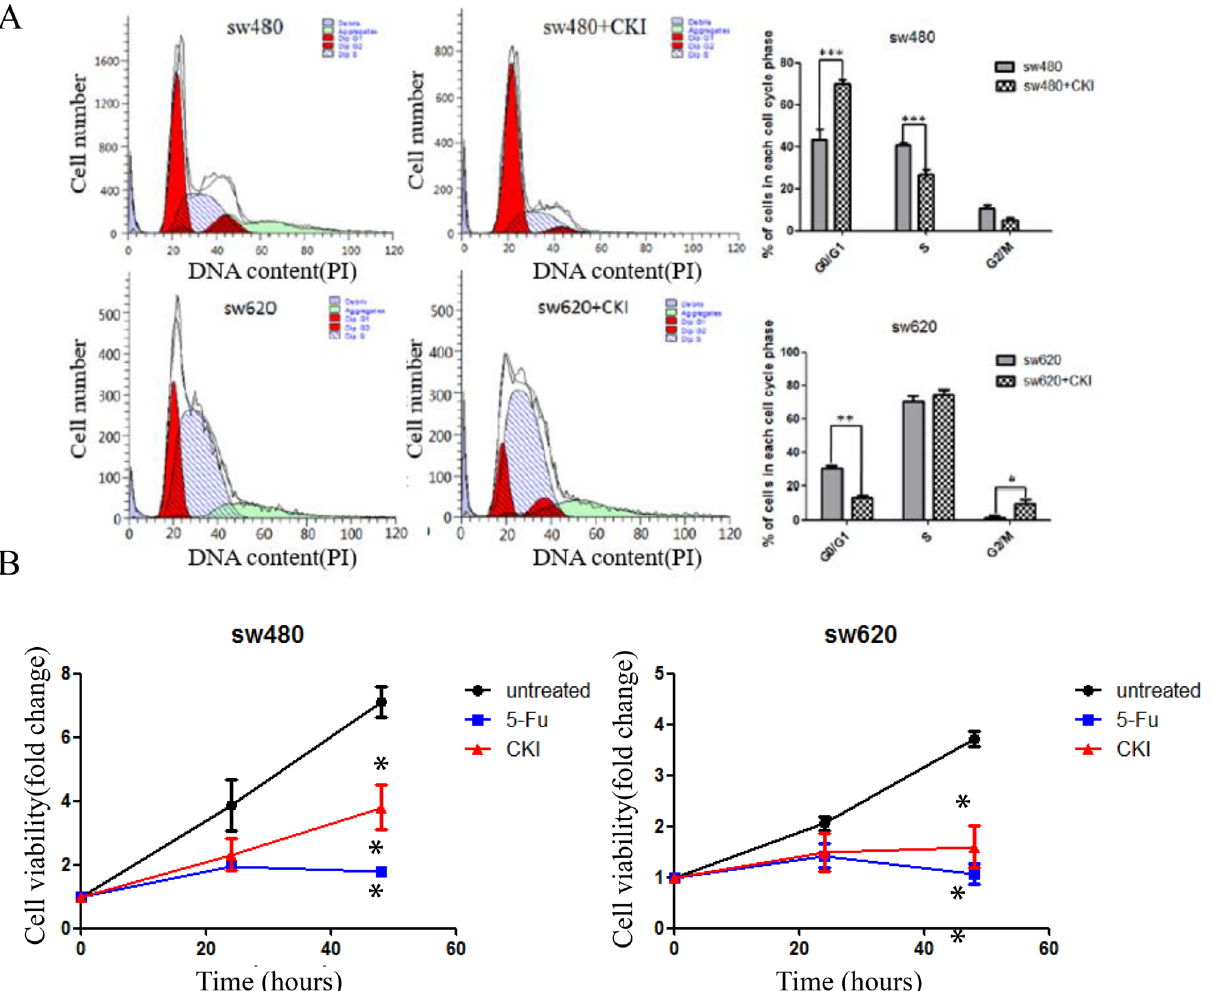
Figure 5. Compound Kushen injection induces the arrest of cell cycle progression and inhibits CRC cell proliferation in vitro. ( A ) Flow cytometry assays were performed to analyze the cell cycle in SW480 and SW620 cells after CKI treatment. Values at different stages of the cell cycle represent the mean ± SD from three independent experiments. ( B ) SW480 and SW620 cell viability was measured under different treatment conditions using CCK-8. Each data point represents the mean ± SD from three independent experiments. * p < 0.05, ** p < 0.01, *** p < 0.001, compared with control. The image was created using GraphPad Prism 5.01